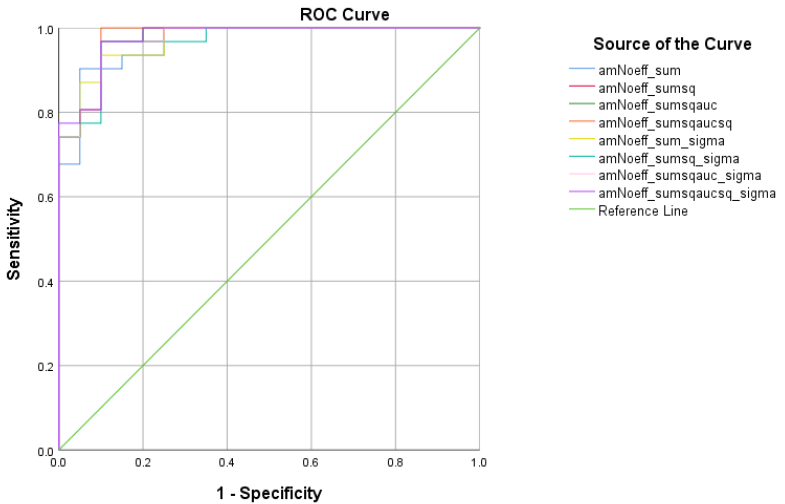
Figure 6. ROC curve analysis of the 8 formulae that better discriminate between Cognitively Healthy Advanced-age Adults (HC) and Mild Cognitive Impairment (MCI).